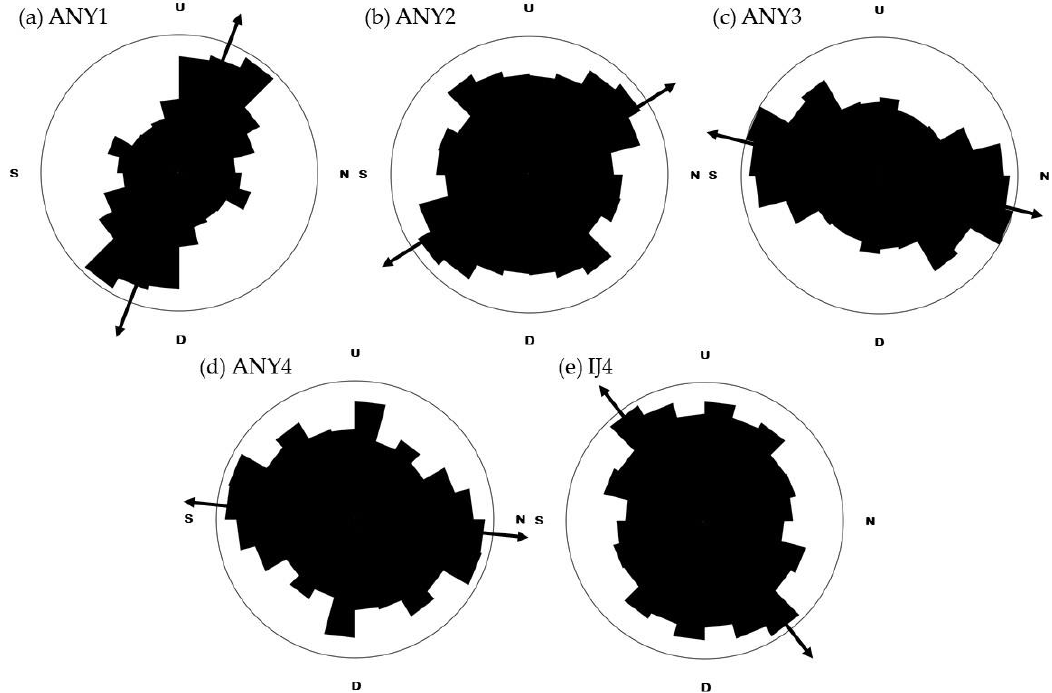
Figure 6. Rose diagrams of vertical slices of ( a ) ANY1; ( b ) ANY2; ( c ) ANY3; ( d ) ANY4 and ( e ) IJ4 specimens that were used in μCT imaging . These diagrams show the distribution of the inclination pores orientation. Vertical axis represents Up-Down direction while horizontal axis represents North-South direction. Black arrows indicate the inclination preferred pore orientation.